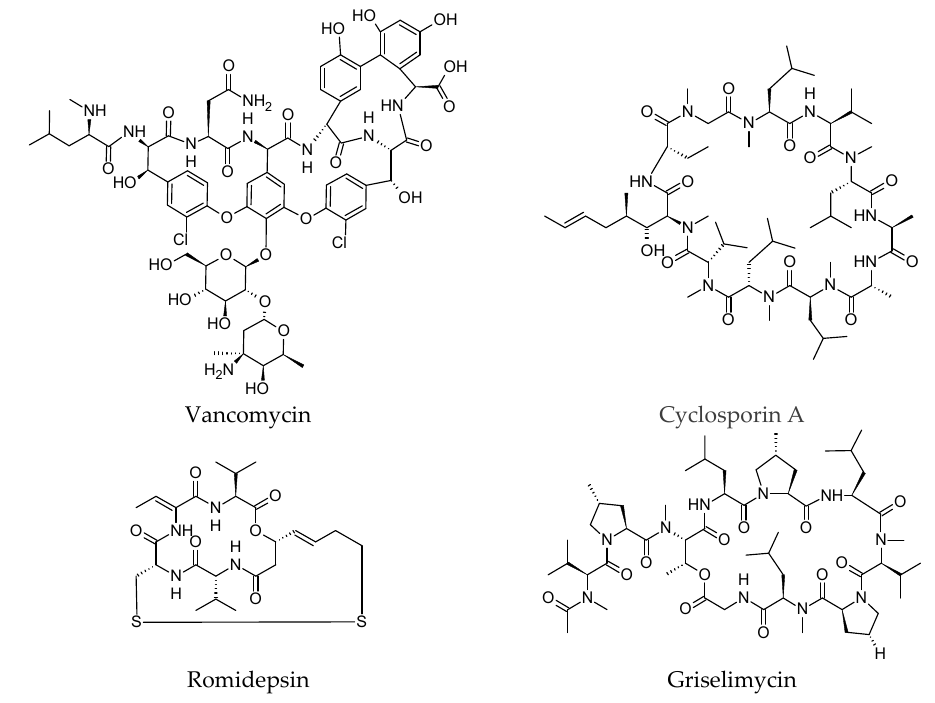
Figure 1. Previously discovered naturally occurring cyclic peptides. Table 1. Previously discovered naturally occurring cyclopeptides and their medicinal significance.